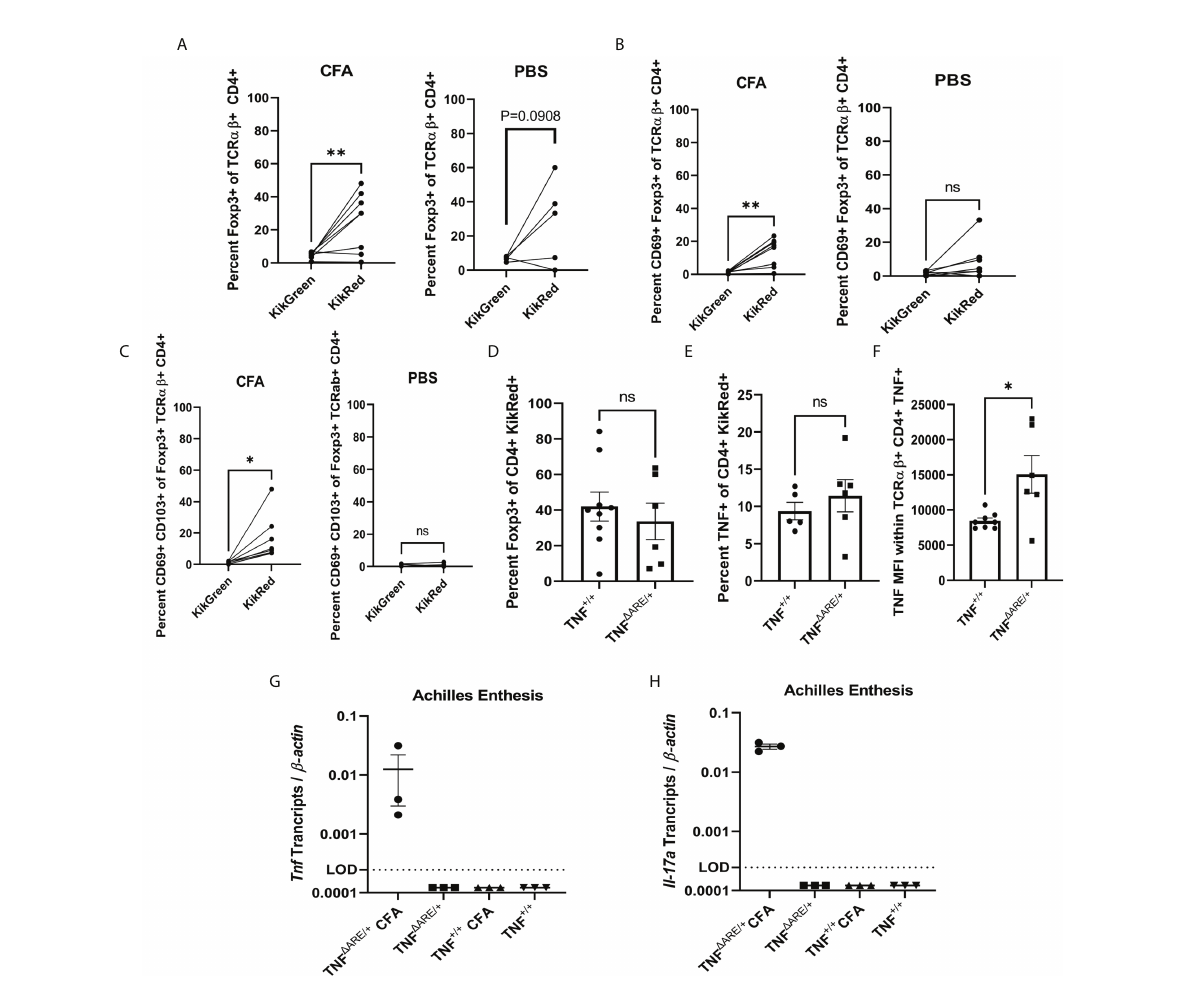
FIGURE 3 Injury induces in fl ux of gut-derived regulatory T cells. 8-10 week old male and female KikGR + (n=5) mice received an injection CFA in the hind hock and PBS in the contralateral hock simultaneously to having undergone photoconversion of the distal colon. 72 hours post injection